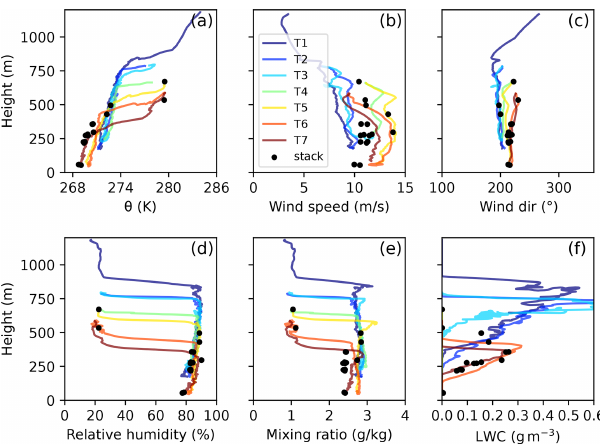
Figure 6. Vertical profiles of the mean potential temperature, wind speed and direction, absolute and specific humidity, and the liquid water content obtained during slant ascents and descents of Polar 6 on its way to and from Polarstern on 2 June 2017. The locations of the ascents and descents are shown in Fig.